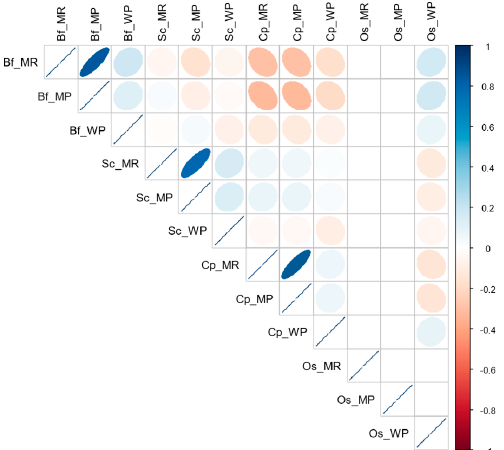
Figure 3. A correlogram highlighting the direction and intensity of the correlation between the abundance of each stemborer species in maize plants of cultivated fields during cropping season and those in either maize residues or wild plants during non-cropping season. The blue color denotes a positive correlation and the red color a negative correlation. Higher intensity of the color indicates a strong correlation. Bf_MR, B. fusca in maize residues; Bf_MP, B. fusca in maize plants; Bf_WP, B. fusca in wild plants; Sc_MR, S. calamistis in maize residues; Sc_MP, S. calamistis in maize plants; Sc_WP, S. calamistis in wild plants; Cp_MR, C. partellus in maize residues; Cp_MP, C. partellus in maize plants; Cp_WP, C. partellus in wild plants; Os_MR, other species in maize residues; Os_MP, other species in maize plants; Os_WP, other species in wild plants. For other species (Os), see Table 2.